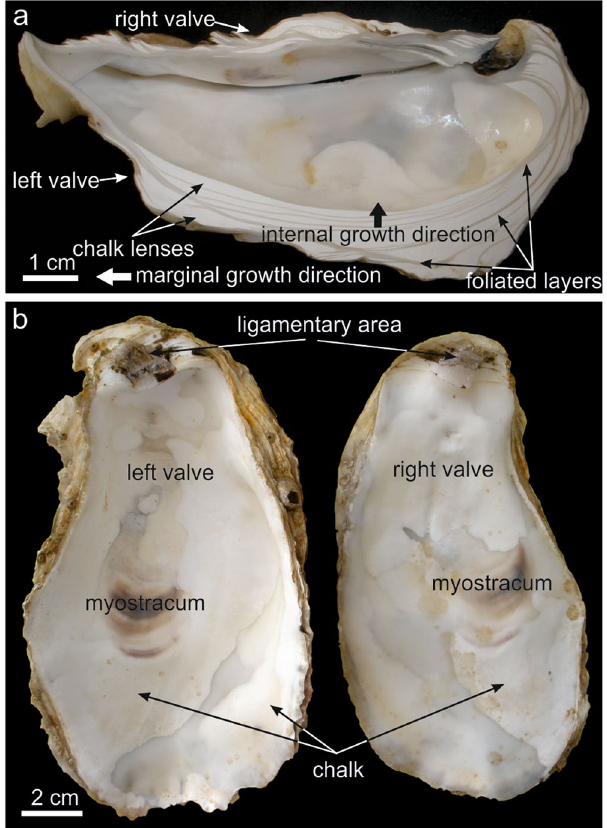
Figure 1. Distribution of chalk and foliated layers in the shells of M . angulata . ( a ) Dorsoventral section through a specimen; the chalk appears milky white, whereas the foliated microstructure is translucent grey. ( b ) Internal views of the valves of a specimen with a particularly wide and pseudosymmetric extension of